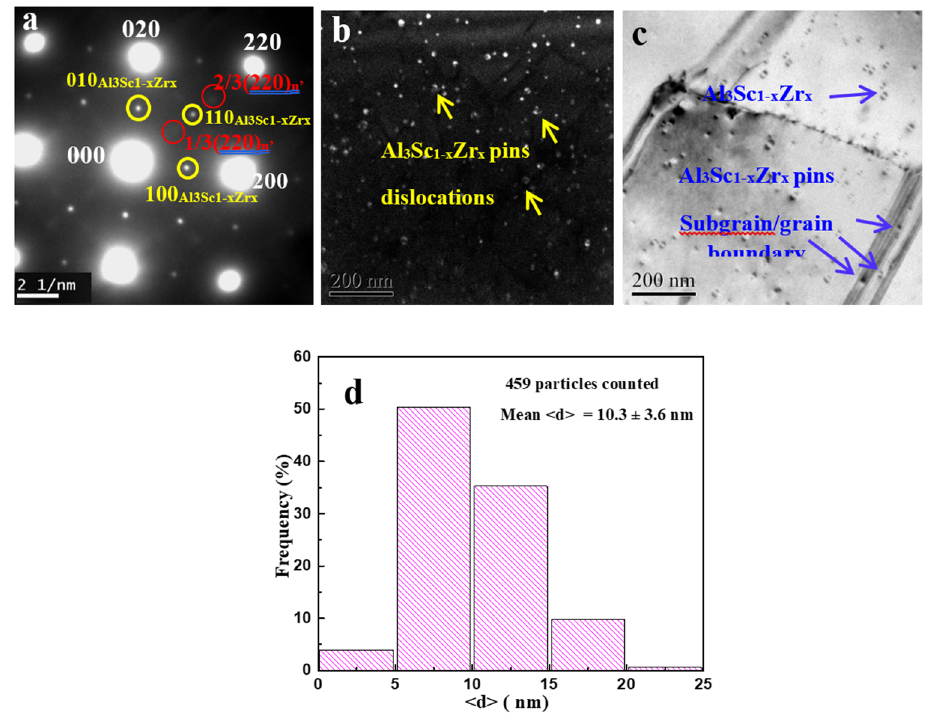
Figure 3. TEM results of precipitates in aged alloys. ( a ) SAD patterns, ( b ) (110) superlattice centered dark field image, showing the interaction between Al 3 Sc 1 − x Zr x particles and dislocations, ( c ) bright-field TEM image, showing the interaction between Al 3 Sc 1 − x Zr x particles and grain / subgrain boundaries, ( d ) size distribution histograms of Al 3 Sc 1 − x Zr x nanoparticles.